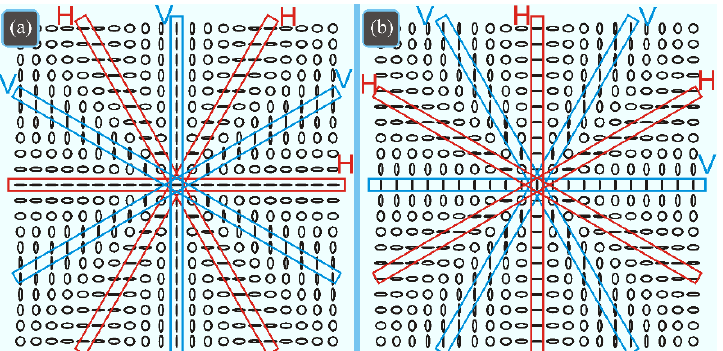
Figure 3. Jones vectors for fields with third-order hybrid ( a ) radial-circular and ( b ) azimuthal-circular polarization ( n = 3). Regions with linear polarization are marked with oblong rectangles. Letters H and V, respectively, mark regions of horizontal and vertical linear polarization.